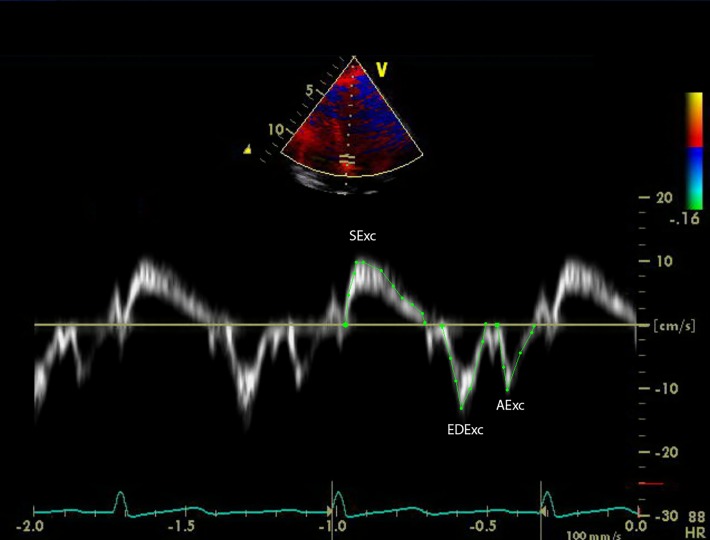
Example of the method for tracing the velocity time integrals of the systolic, early diastolic and atrial contraction tissue Doppler signals from the mitral annulus.